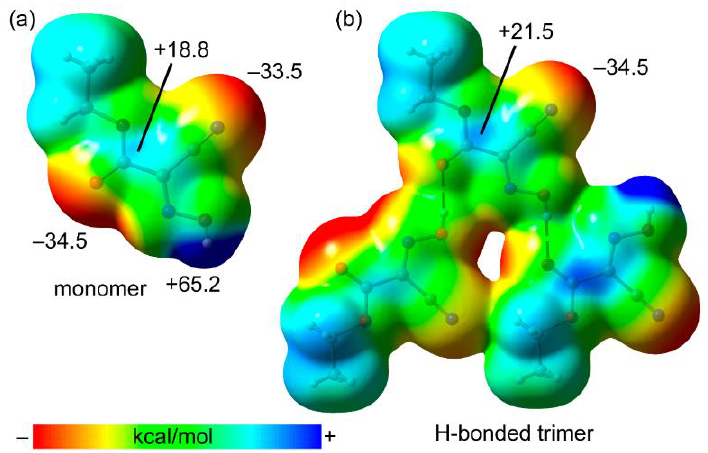
Figure 4. MEP surfaces of a monomer ( a ) and trimer ( b ) of Oxyma at the PBE0-D3/def2-TZVP level of theory (isosurface 0.001 a.u.). The energies at selected points of the surface are given in kcal/mol.